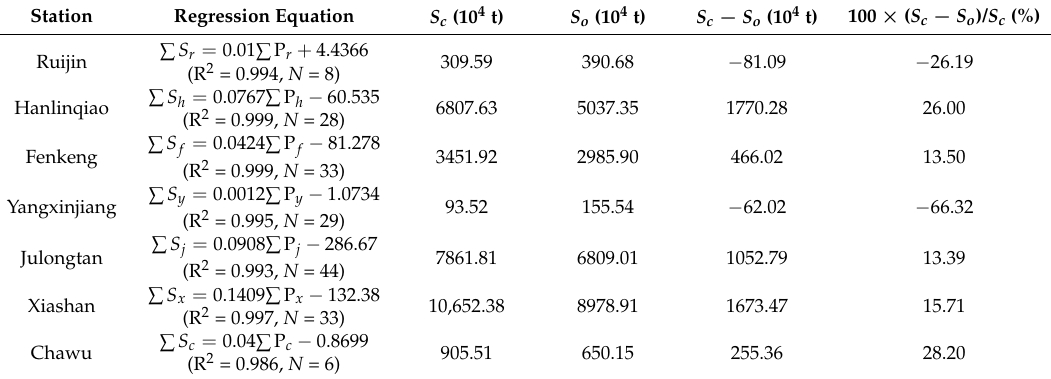
Table 4. The cumulative sediment discharge calculated by the linear regression equations before the transition years.